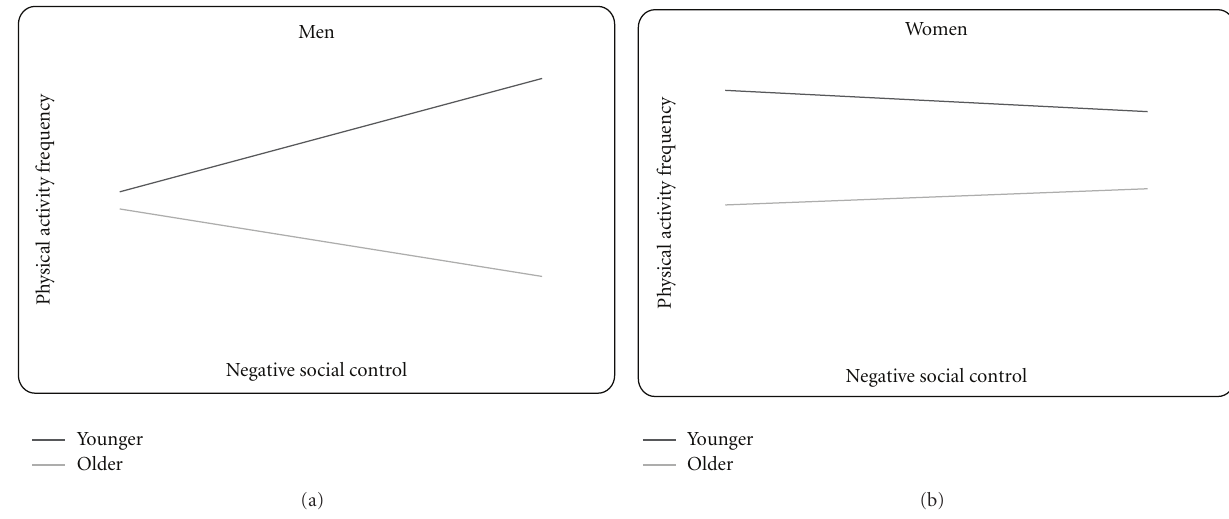
Figure 2: (a) The interaction of age and negative social control on physical activity for men. (b) The interaction of age and negative social control on physical activity for women. Note: the figures show predicted regression lines for one standard deviation above (high) and one standard deviation below (low) the mean of negative social control. The simple slope is statistically significant for older men.